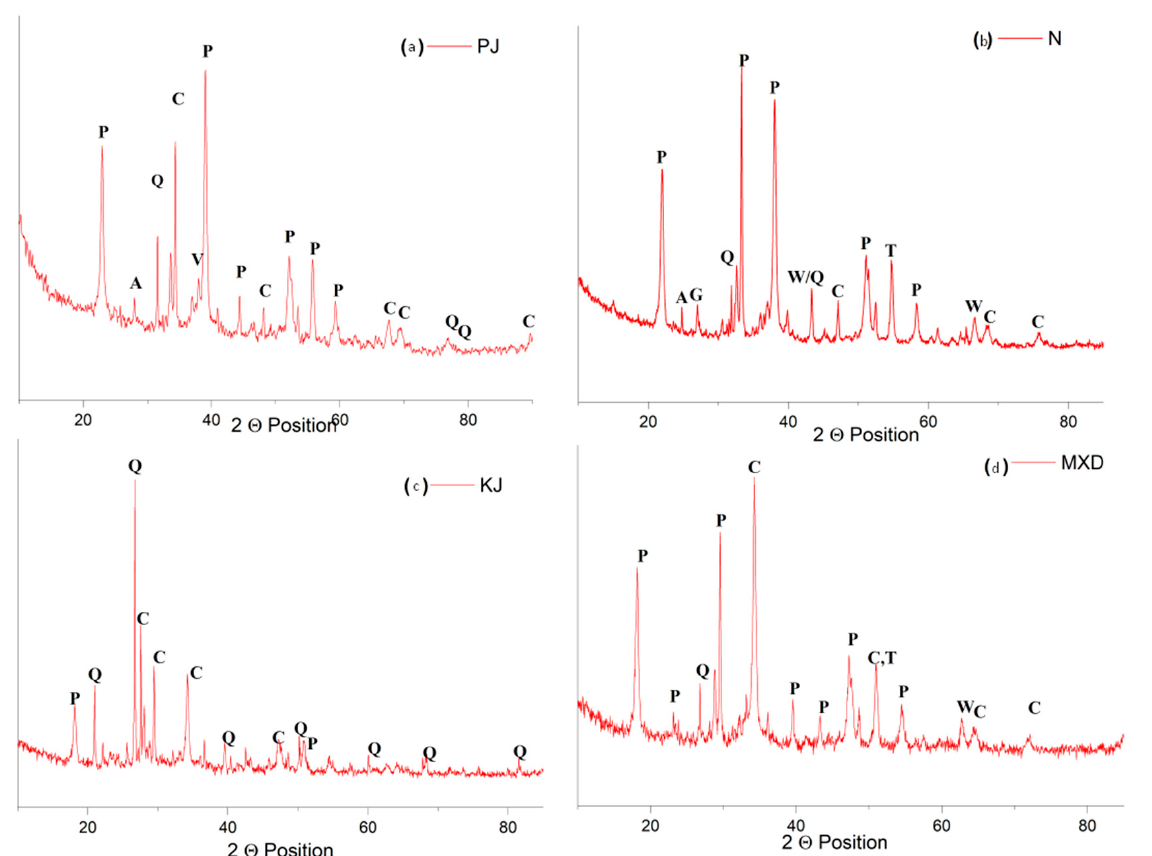
Figure 9. XRD patterns at 56 days ( a ) jaggery mortar; ( b ) neelamari lime mortar; ( c ) kadukkai + jaggery mortar; and ( d ) kadukkai + jaggery + aloe vera (MXD) mortar. P: portlandite, C: calcite, A: aragonite, T: Tobermorite, Q: quartz, V: vaterite, G: gismondine-(CSH), W: Weddellite.